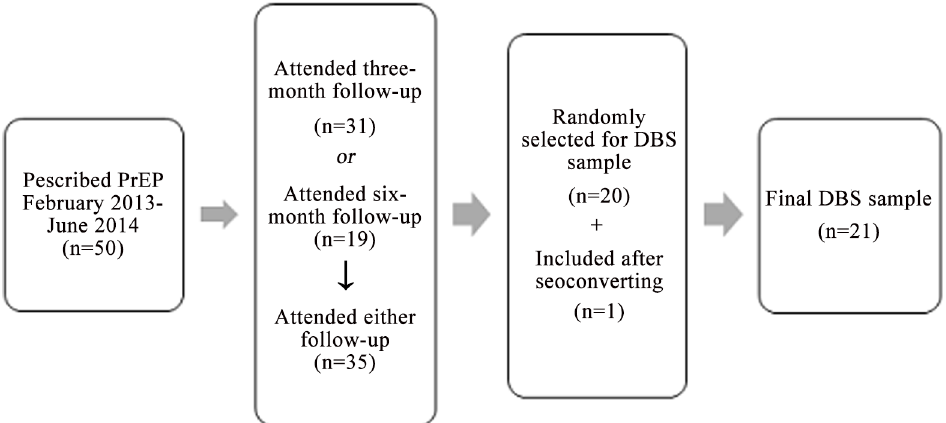
Fig 1. Sample selection for dried blood spot (DBS)